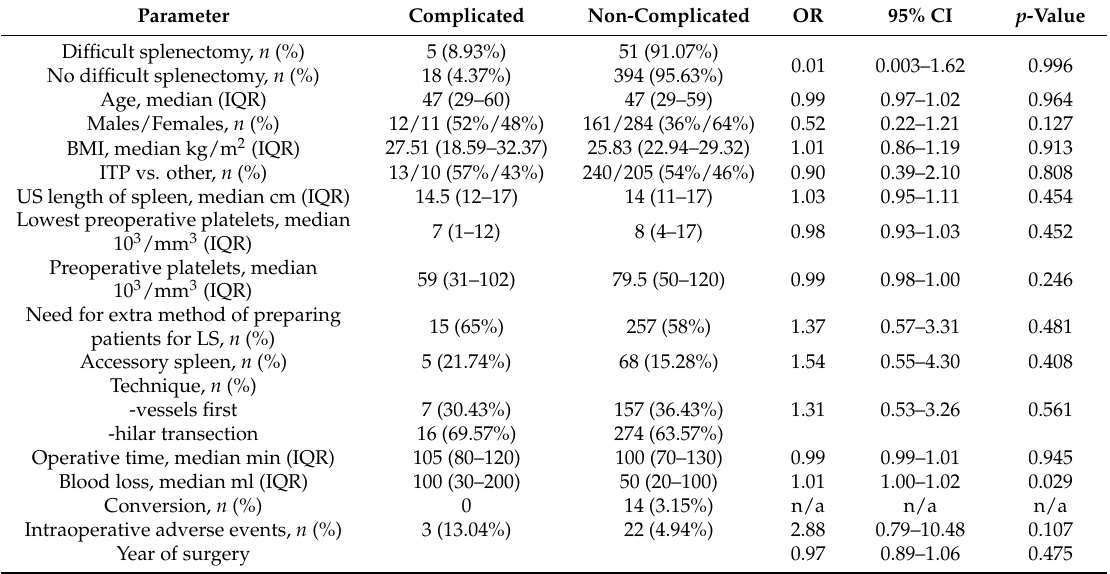
Table 7. Risk factors for perioperative serious perioperative morbidity (Clavien–Dindo III–V).